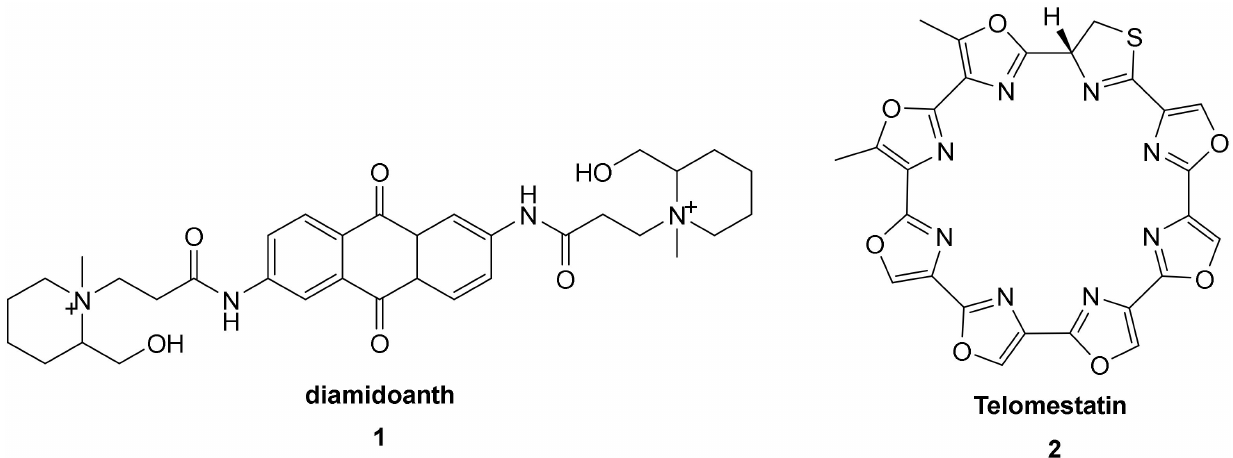
Figure 3. Structure of 2,6-bis[3-(4-methylpiperazino)proprionamido]-anthracene-9,10-dione 1 and telomestatin 2